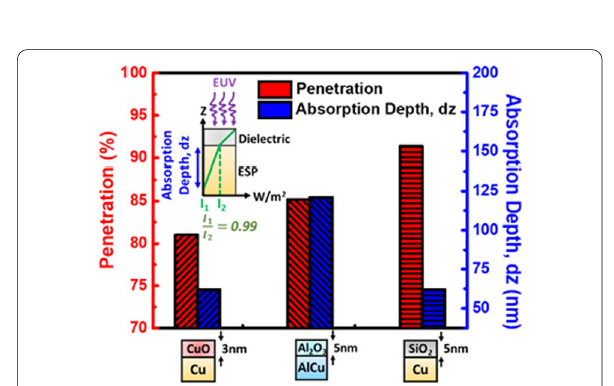
Fig. 6 EUV penetrated percentage through oxide and ESP absorption depth of different oxide/metal compositions